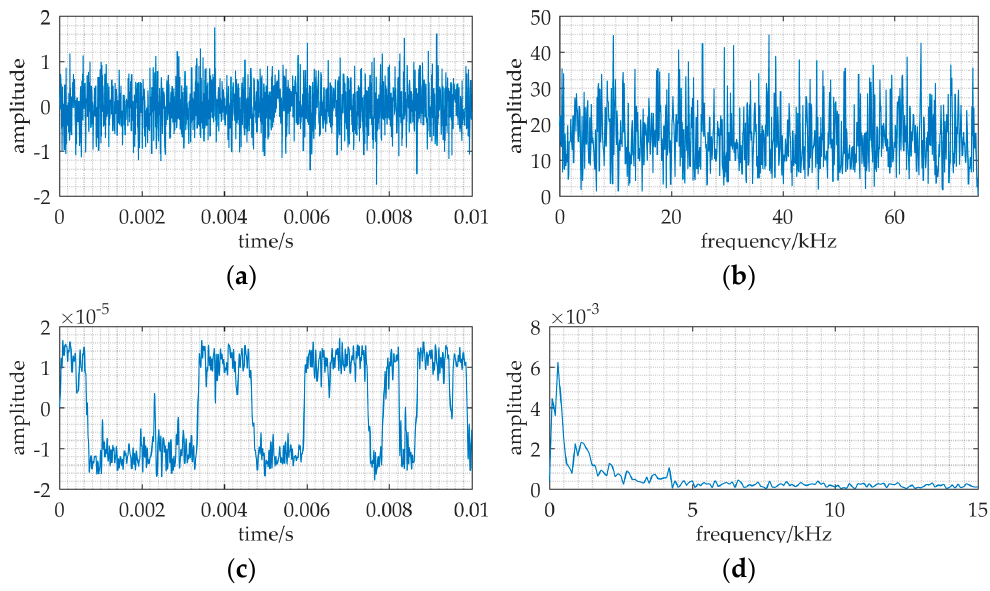
Figure 15. The input and output of a tank experiment where MNSR used to detect the ULB signal. The relative parameters: f = 37.5 kHz, a = 3×10 4 , b = 1.9×10 14 , f c = 37.8 kHz, D = 0.22, f s = 150 kHz. (a, b)